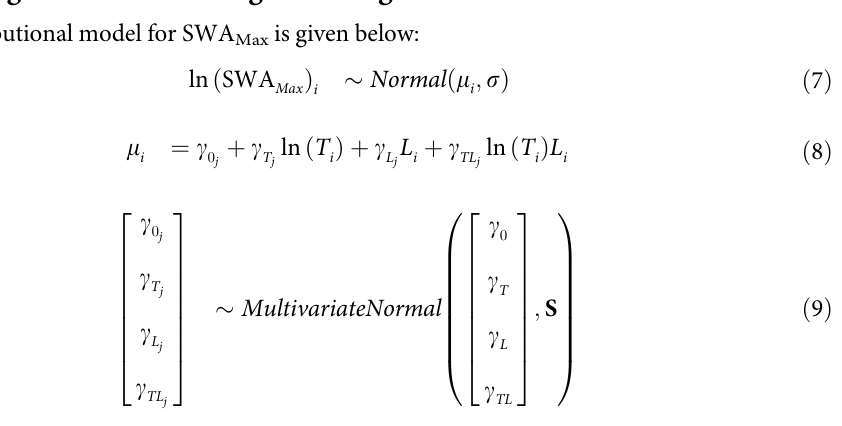
S1 Fig. Sample steering wheel trace and identification of SWA . SWA is the difference Max Max between the initial steering wheel angle and the maximum steering wheel angle, taken within a 2 s time window. S2 Fig. Examining the relationship between SWA and reaction time. Plotted are the four Max Repeated TLC conditions. In every failure condition, there is a strong positive correlation F between RT and SWA . Pearson’s R values range from.53 to.68 (mean = .61). The marginal Max means and standard deviations for RT and SWA are shown as dots close to their respective Max axis. The ACMT (SupAuto+ACMT) consistently slows reaction times. The average difference between SupAuto+ACMT and SupAuto conditions (averaging across each participant’s mean difference between median RTs) is.19 s (SD = .37; one sample t-test comparing to zero differ- ence: t (18) = -2.26, p = .04). Given the strong correlations one might expect this slowing to translate to SWA but in fact the condition averages for SupAuto and SupAuto+ACMT are Max approximately equal. The average difference between SWA for SupAuto+ACMT and Max SupAuto conditions is only.21˚ (SD = 4.0; one sample t-test comparing to zero difference: t (18) = .22, p =